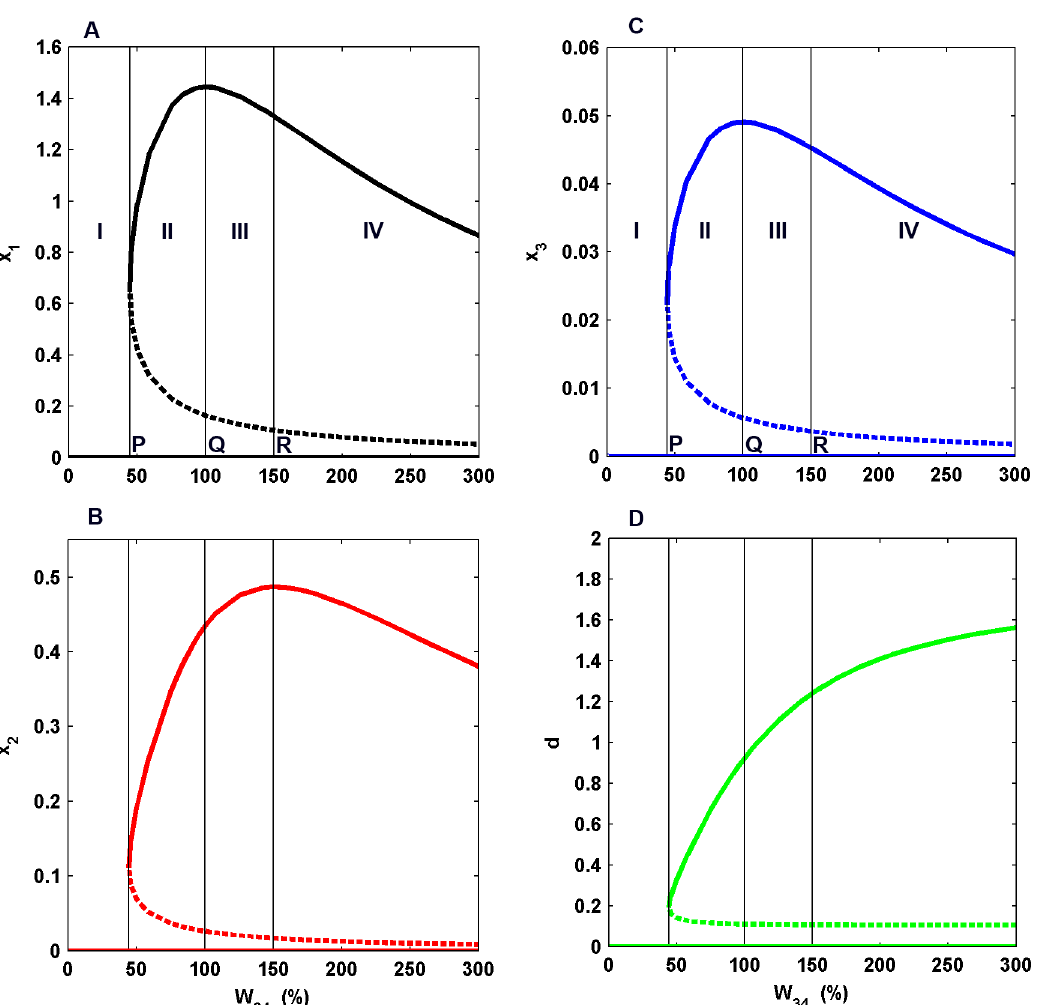
Fig 3. Bifurcation Diagrams. These curves depict the equilibrium activity of the pyramidal neurons (A), inhibitory neurons (B), dopaminergic neurons (C) and D1 receptor activation (D) versus the bifurcation parameter W 34 . The solid (dotted) lines portray stable (unstable) states of the system. The curves are partitioned into four regions I, II, III and IV. Point P, Q and R are the boundary points of these regions. Point P is the point at which bistability appears in the system. Point Q is the point of maximum equilibrium activity of excitatory neurons and Point R is the point of maximum equilibrium activity of interneurons.